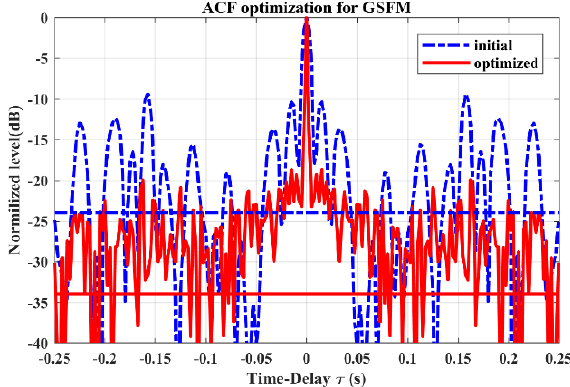
Figure 6. The ACF optimization for GSFM pulse train. The horizontal dotted blue line and solid red line, respectively, represent the average ACF sidelobe level before and after optimization.